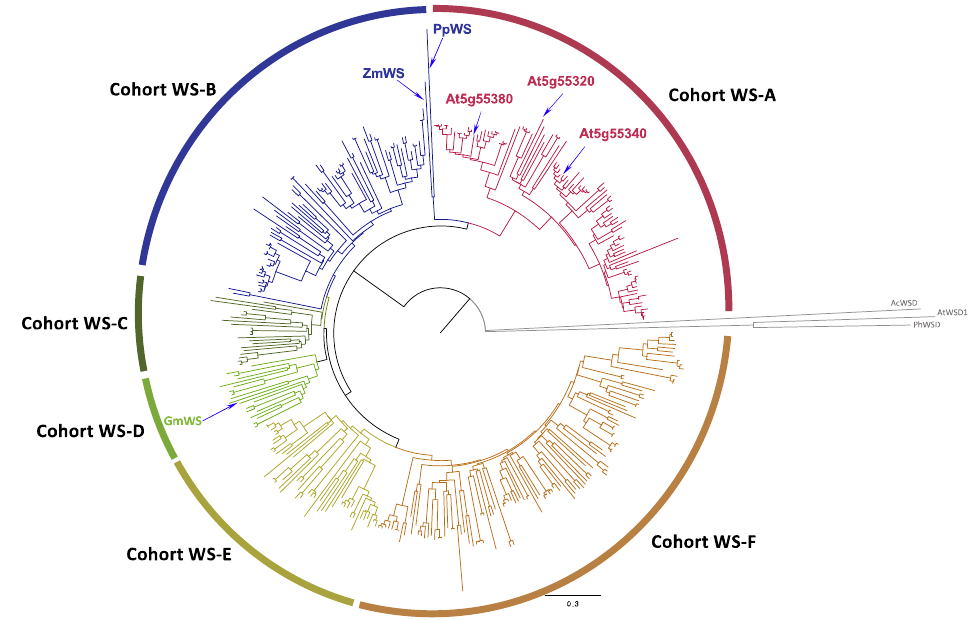
Figure 1. Phylogenetic analysis of MBOAT-type wax synthases. The 375 sequences used in these analyses are identified in Table S1, and these sequences were identified by sequence homology to the jojoba WS sequence (Accession AAD38041.1) using TBLASTP. The phylogenetic tree was assembled with neighbor joining method, using the experimentally characterized WSD sequences from Arabidopsis (AtWSD1) [26], A. calcoaceticus (AcWSD) [24] and P. hybrida (PhWSD) [31] as the outgroup, and the statistical rigor of the tree was tested with a bootstrap calculation ( n = 1000). Similar BLASTP analyses the NCBI RefSeq database using the archetypal WSD protein sequence from A. calcoaceticus (ADP1) [31] and the Arabidopsis AtWSD1 sequence [26] as the initial queries, identified 1054 WSD homologs (bit score > 200); these sequences are identified in Table S2. Phylogenetic relationship among these sequences indicate that they segregate into five clades, labeled as WSD-A to WSD-E (Figure 2). In contrast, to the WS sequences that are restricted only to Plantae, the WSD sequences are found in Plantae and bacteria (Table S2). The two clades that are most distinct from the query sequence (WSD-D and WSD-E) are populated by only bacterial sequences, which are restricted to Proteobacteria and Actinobacteria. The sequences populating WSD-A to WSD-C clades are only from Plantae. The Plantae sequences divide into the Eudicots (clade WSD-A) and Monocots (clade WSD-B), and clade WSD-C contains sequences that are from a mixture of vascular Eudicots and Monocots, and non-vascular Bryophytes (mosses). All 11 Arabidopsis WSD homologs reside in the WSD-A clade, within the Brassicaceae Family